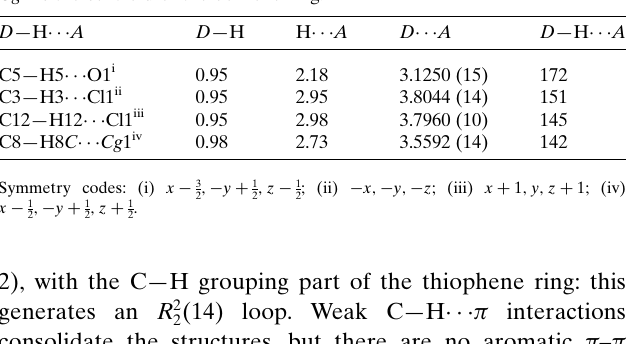
Table 4 Hydrogen-bond geometry (A˚ , (cid:4) ) for (IV). Cg 1 is the centroid of the benzene ring.